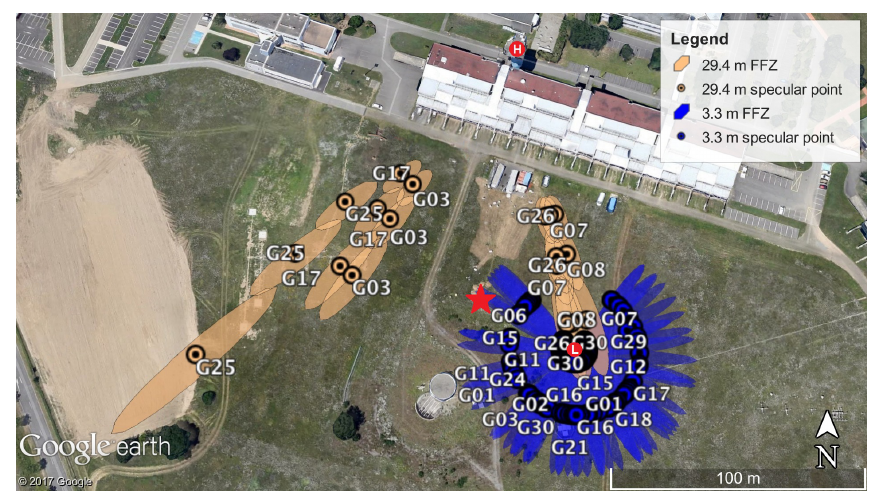
Figure 1. Experimental site of Meteopole-Flux. The specular reflection points and first Fresnel zone (FFZ) areas from the selected satellite tracks are shown in orange for a 29.4m GNSS antenna (“H” red dot). The specular reflection points and FFZ areas for a 3.3m GNSS antenna (“L” red dot) are shown in blue. The red star indicates the location of in situ soil moisture observations. Background geographic information is from Google